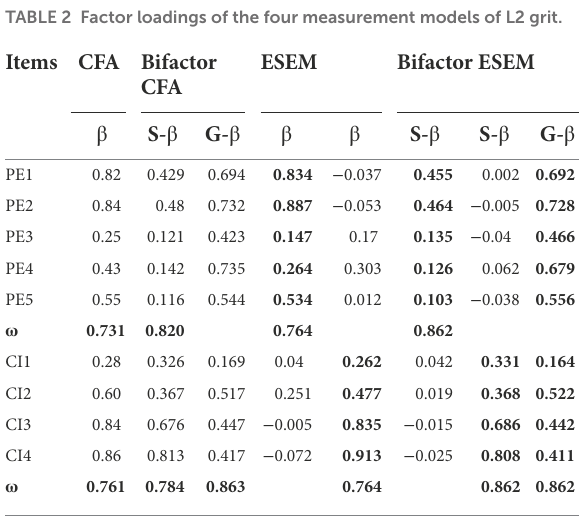
TABLE 2 Factor loadings of the four measurement models of L2